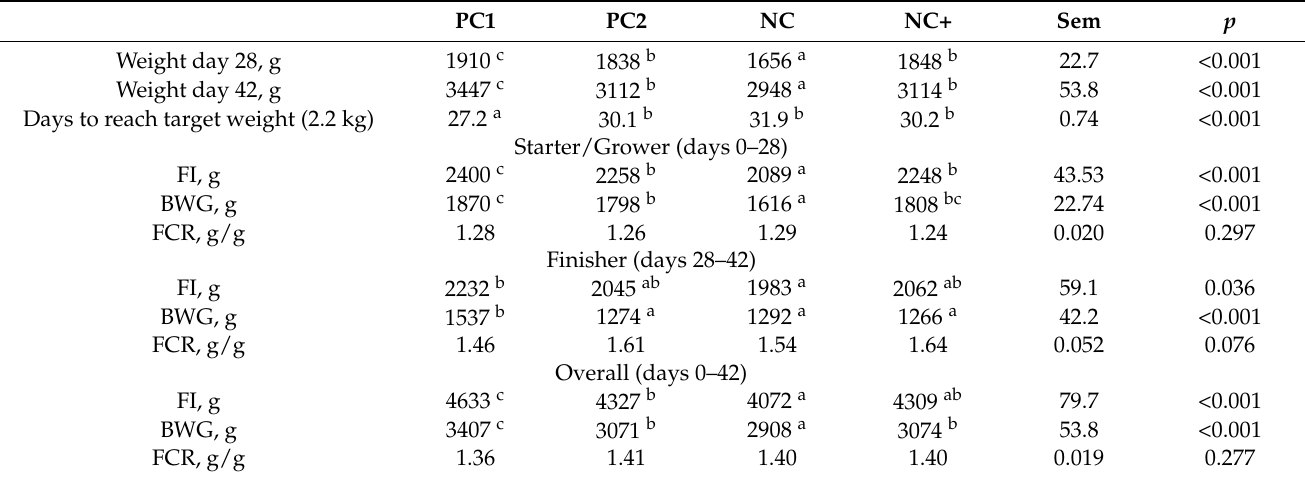
Table 3. Broiler production performance and body composition of birds offered the different dietary treatments during the starter/grower, finisher and overall